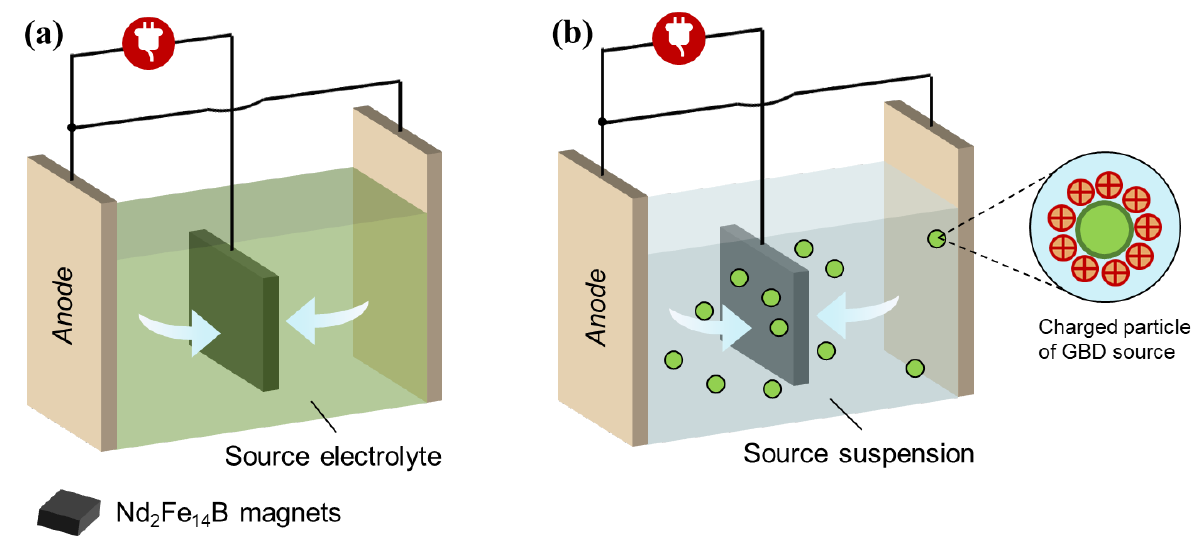
Figure 7. Schematic of electrodeposition methods for GBD sources: ( a ) electroplating and ( b ) electrophoresis. The GBD source particle is assumed to be electropositive in ( b ).